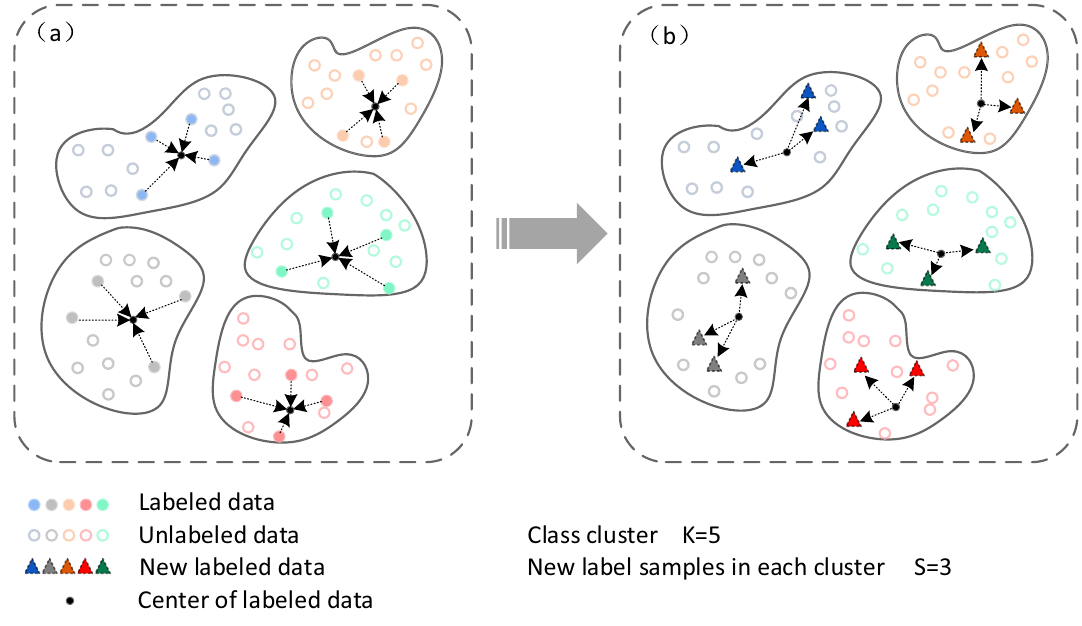
Figure 3. K-nearest neighbors (KNN) label